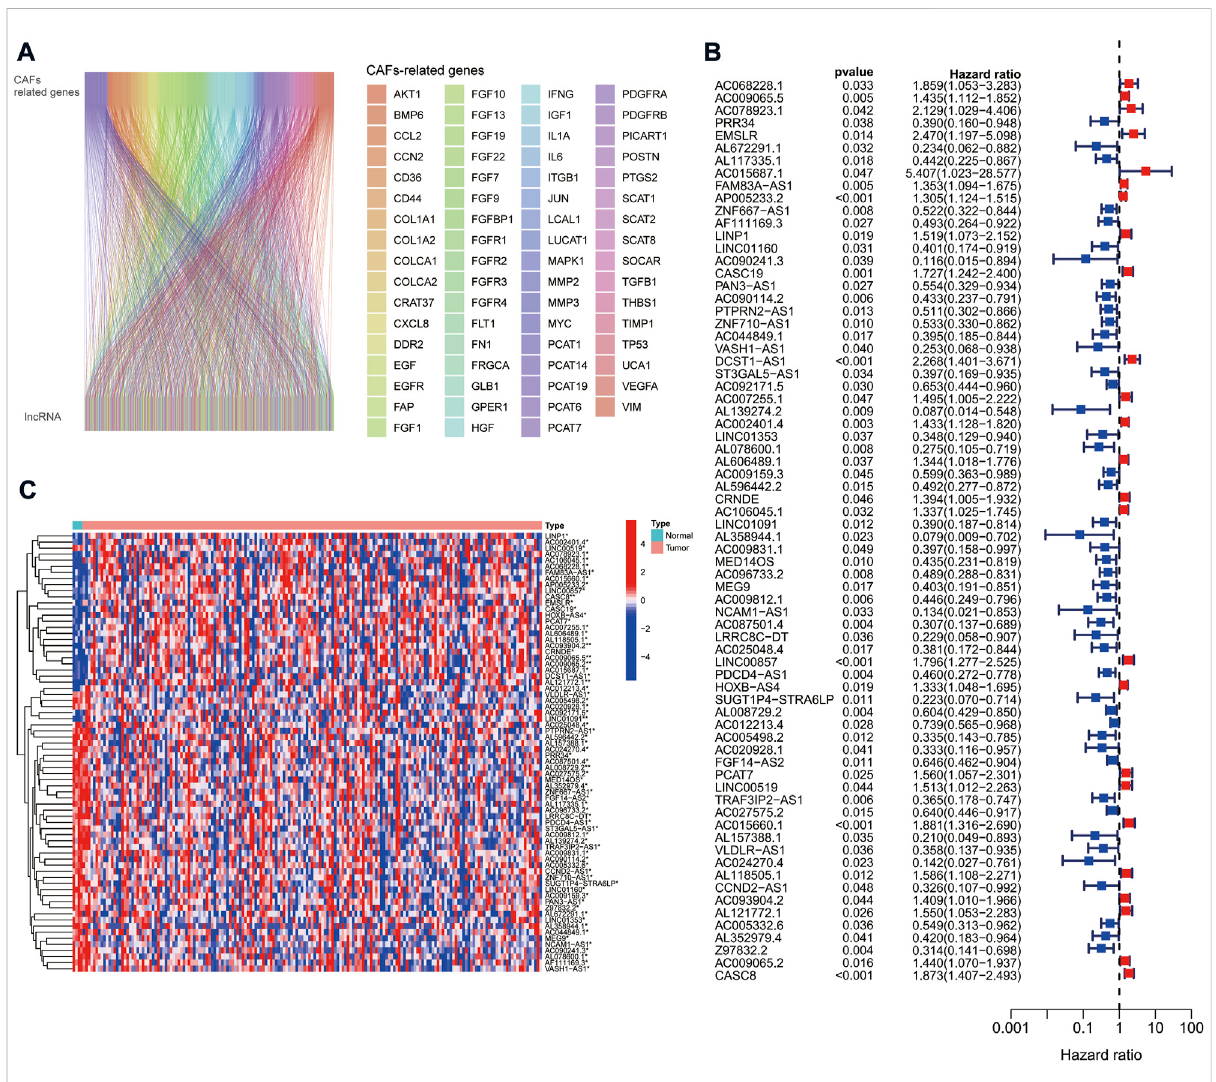
FIGURE 1 CAFs-associated lncRNAs in PAAD. (A) Sankey co-expression network plot of CAFs-associated genes and lncRNAs. (B) Prognostic forest plots showing the 72 CAFs-associated lncRNAs extracted by univariate Cox regression analysis. (C) Heat map of the 72 CAF-associated lncRNAs expression in normal and tumor